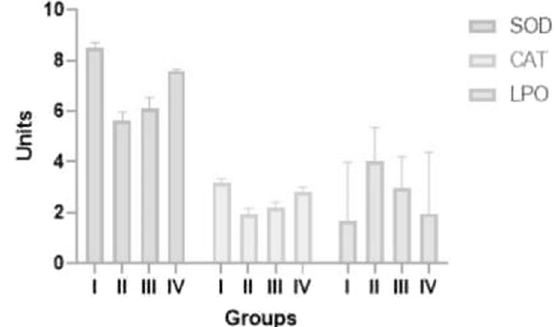
Fig. 13 Antioxidant levels of Trichoderma viride on different